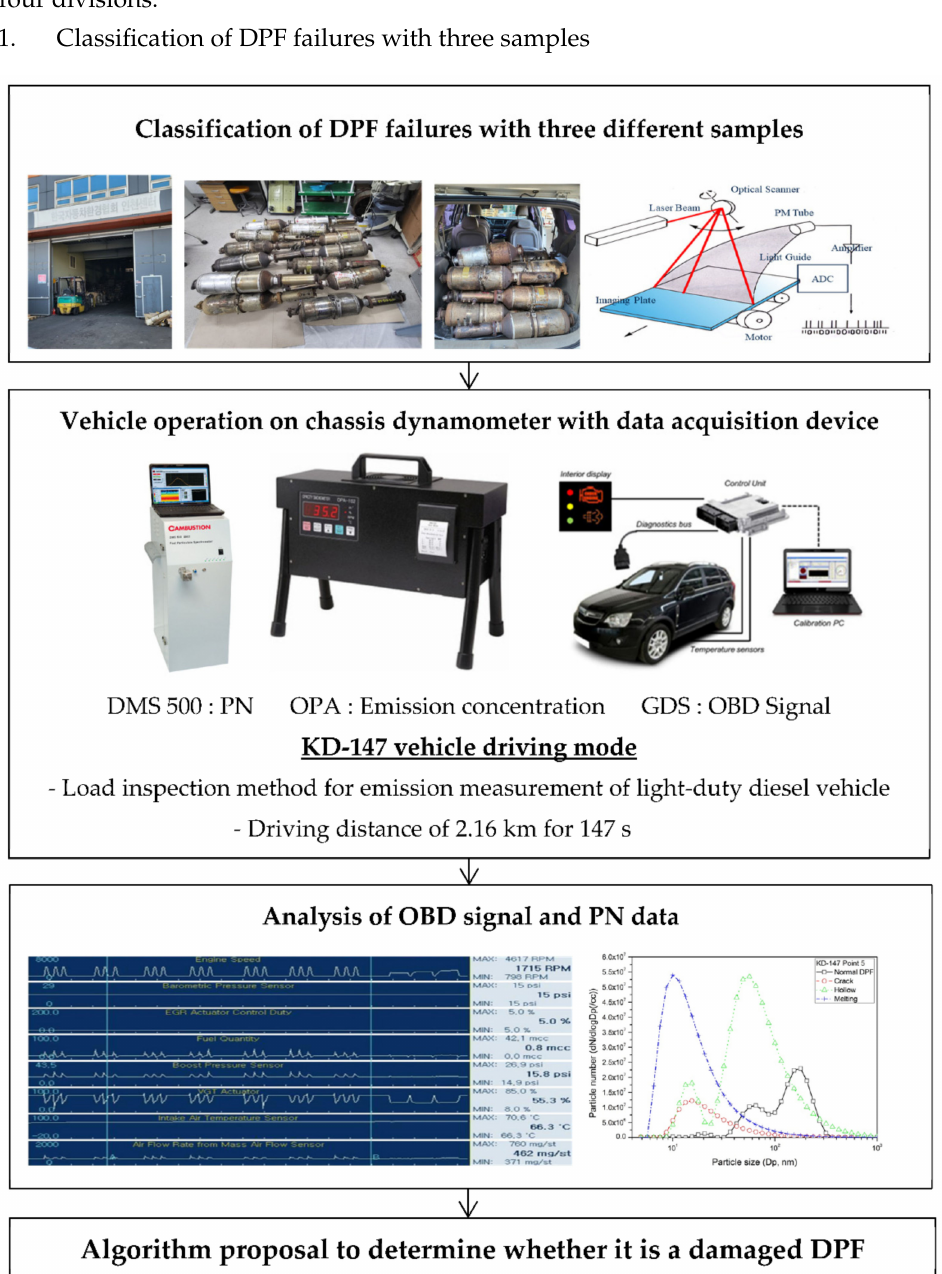
Figure 1. Flowchart detailing this research